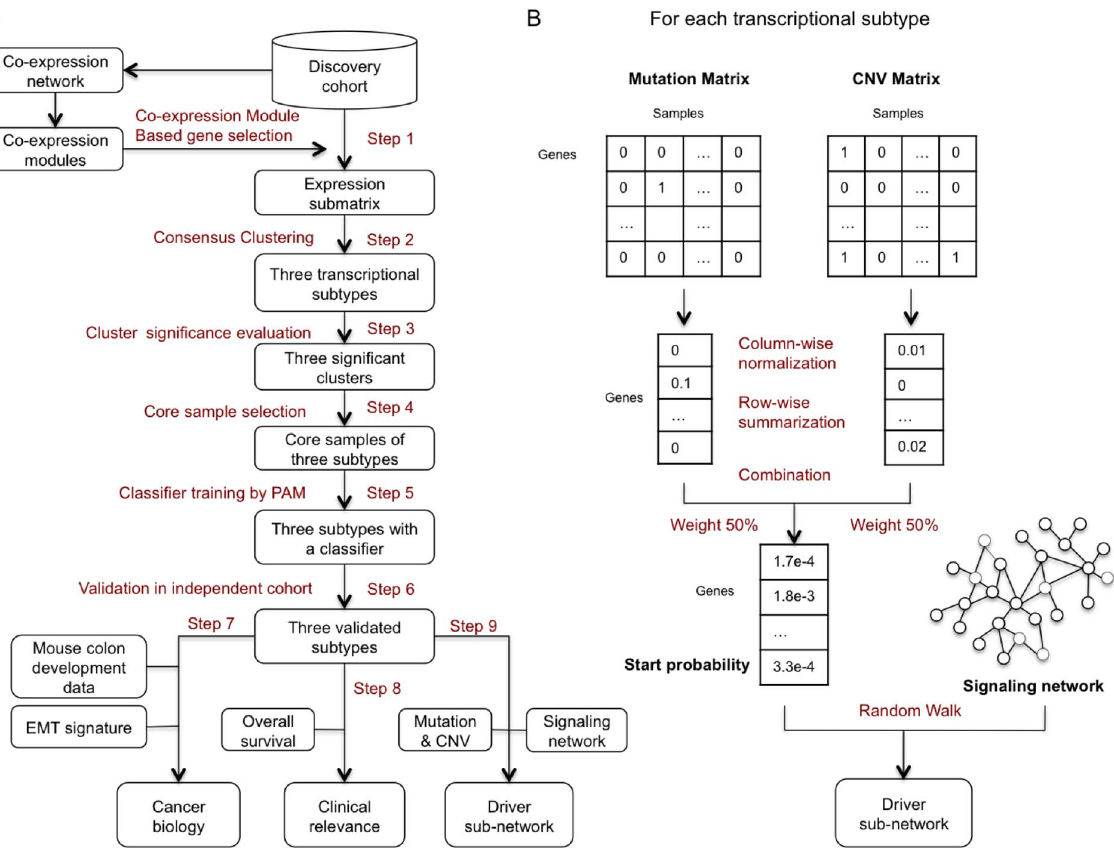
Figure 1. Schematic overview of methods used. (A) Study design. A detailed description of methods and data used in the study can be found in Table S2 in File S1; (B) Overview of the method used for inferring upstream driver subnetworks for individual subtypes.